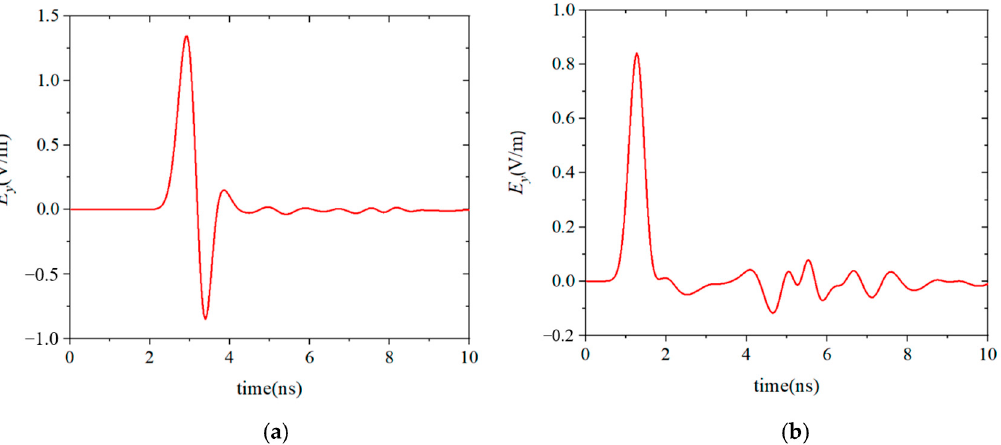
Figure 5. The calculated results of the HIE-FDTD method when the thickness of each dispersive medium layer is 3 nm. ( a ) Results of the observation point behind the plate. ( b ) Results of the observation point before the plate.